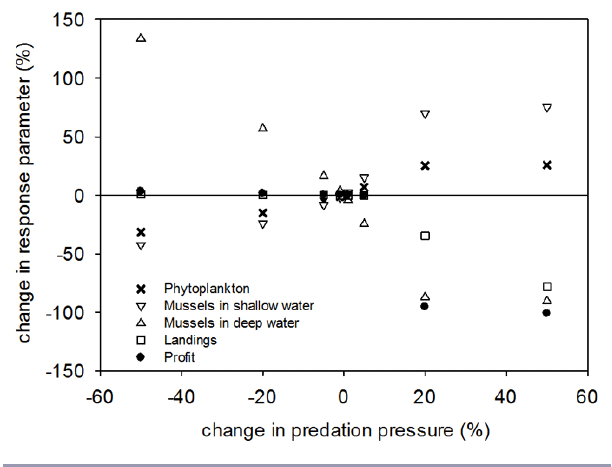
Fig. 5 . Model sensitivity to changes in predation pressure for mussels in deep water. Results are shown as percent change in response parameters relative to the hindcast simulation.